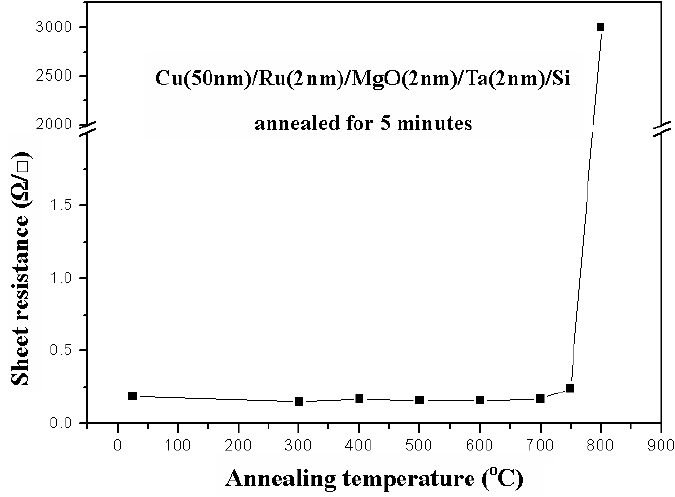
Figure 8. Relation between sheet resistances and annealing temperatures for a Cu (50 nm)/Ru (2 nm)/MgO (2 nm)/Ta (2 nm)/Si structure annealed for 5